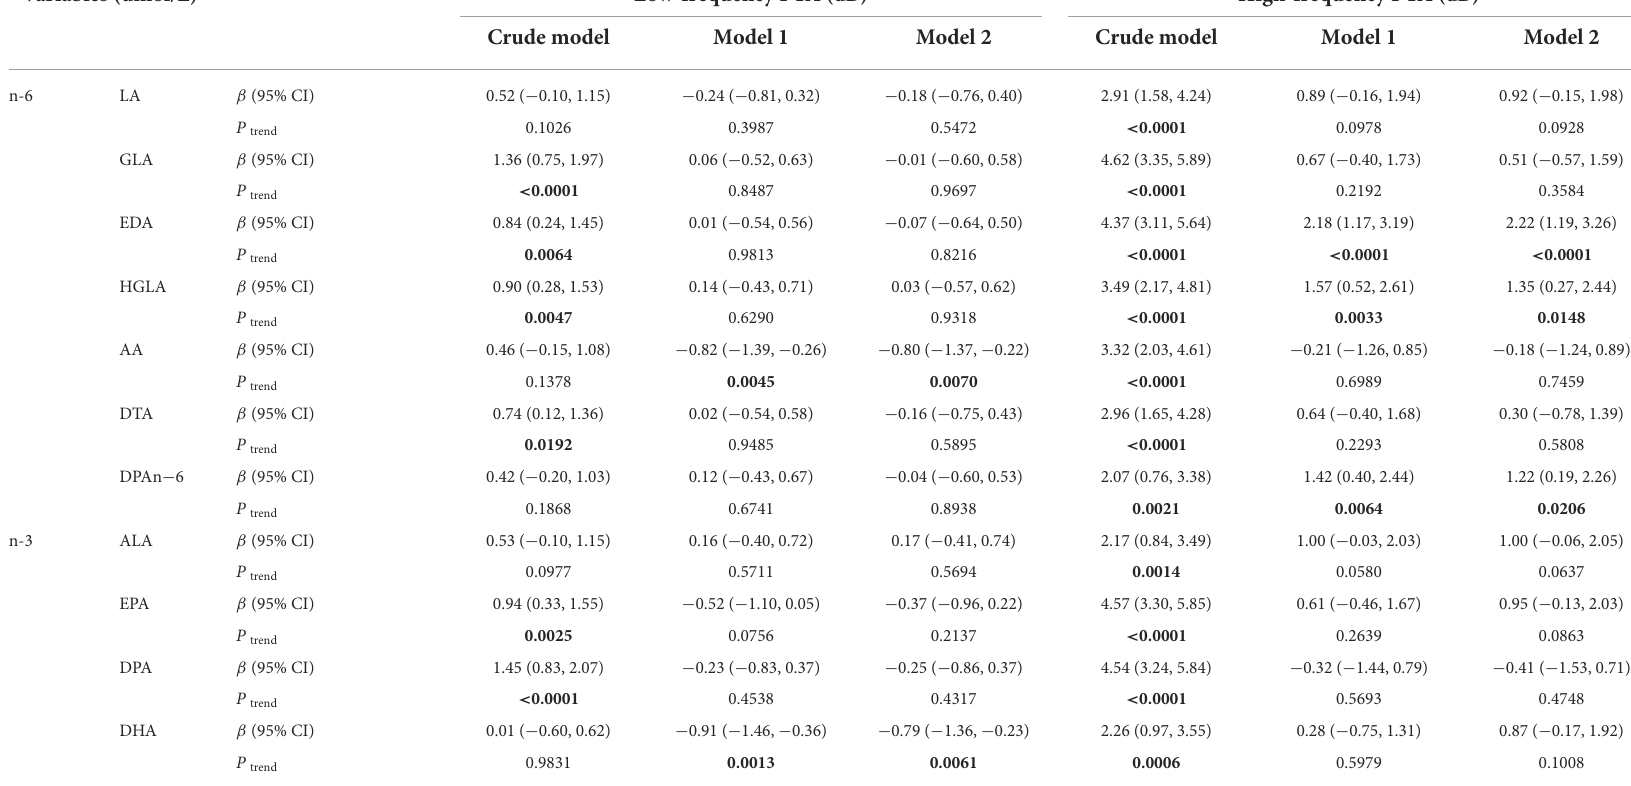
TABLE 2 Multivariable linear regression model of outcomes of hearing